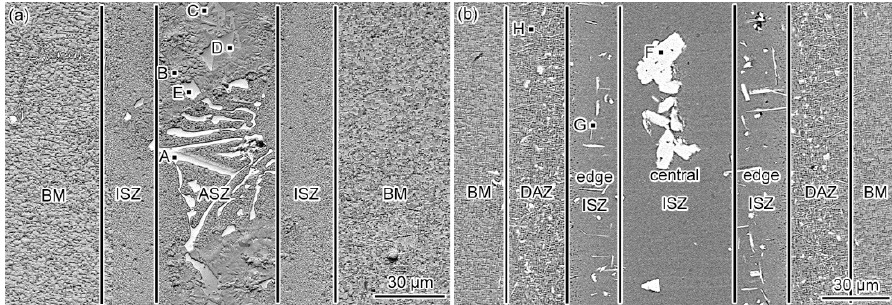
Figure 2. The microstructure of ( a ) as-prepared and ( b ) PBHT-processed joints.